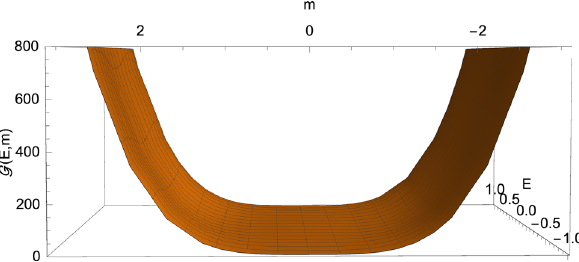
Fig. 4 The function (3.5) with C = 1. It is clear that the discriminant (3.4) never becomes negative provided C 2 E 2 ≤ 1 (cf. Eq.